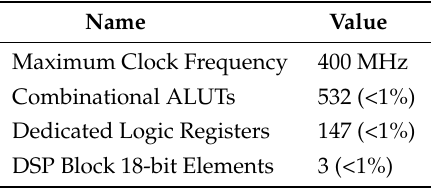
Table 3. Basic Features of the Resampler and FPGA resources (StratixIV-EP4SGX230KF40 implementation).